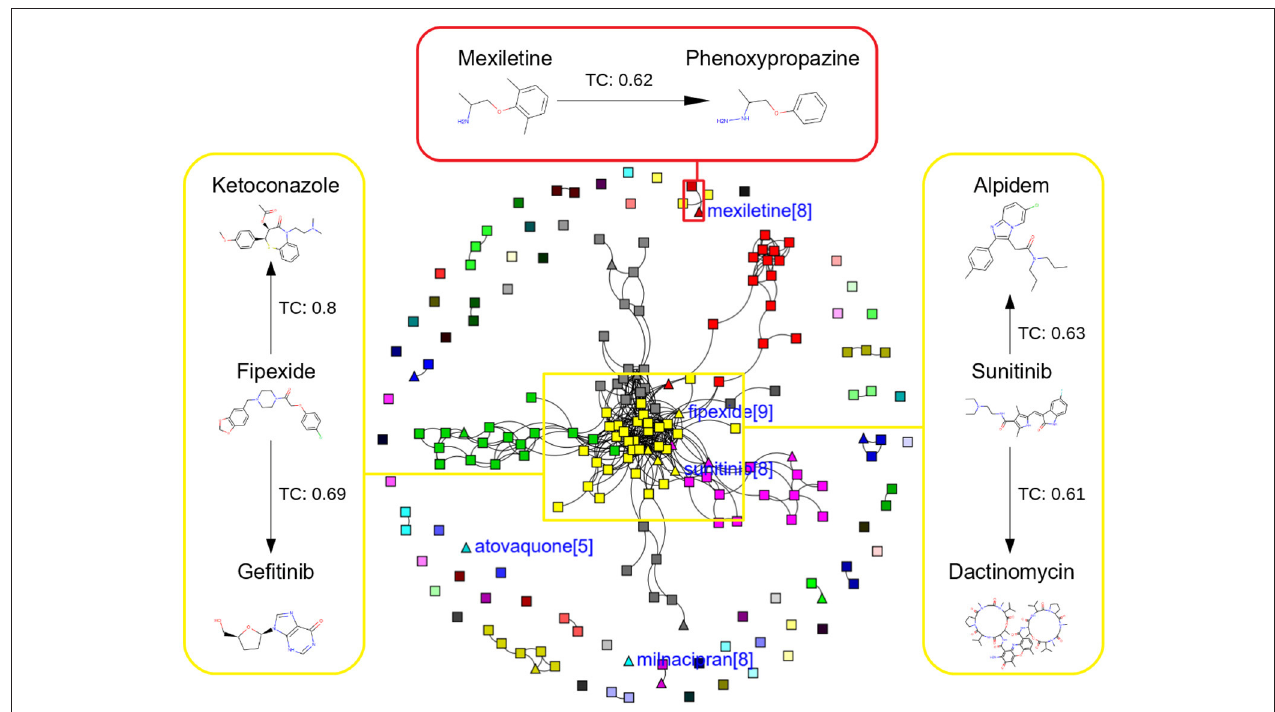
FIGURE 5 | Chemical Space Networks of the actives of external test set (triangle) and actives of training set (square). The CSNs reveals that mexiletine (external test active) compound having similarity with phenoxypropazine (training set active) is incorrectly predicted by all the sampling methods as inactive. Similarily fipexide, sunitinib (external set active) are incorrectly predicted by all the sampling